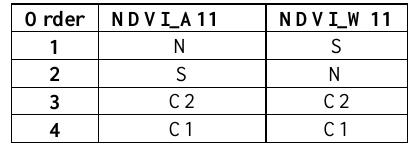
Table 5. ASTER and WV-2 AOI ranking based on average NDVI values.